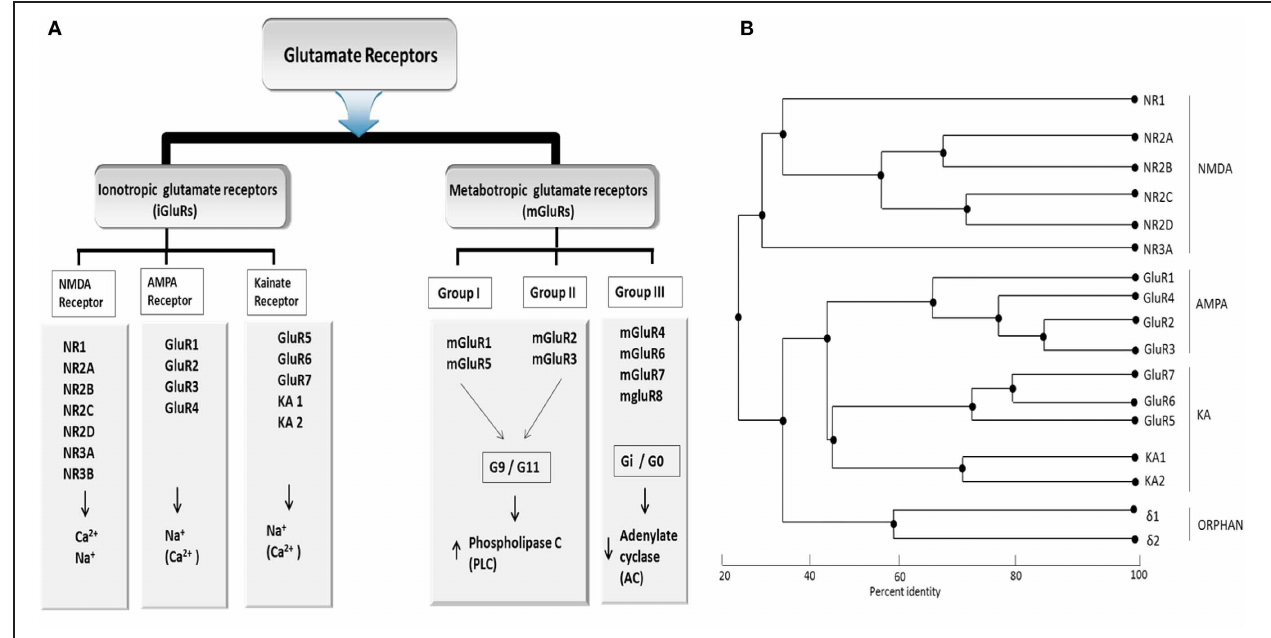
score derived from the pairwise sequence similarity score according to Feng and Doolittle, 1987. PLC, Phospholipase C; AC, Adenylaste cylase; downwards arrow, decrease; upwards arrow, increase concentration. Adapted from Kew and Kemp